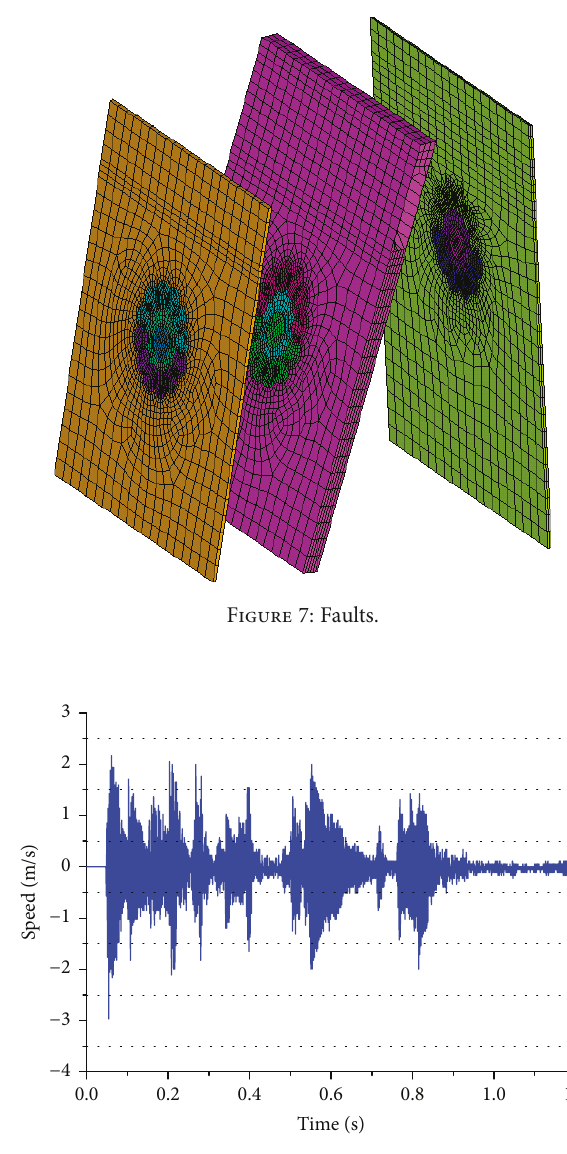
Figure 8: Blasting velocity wave.